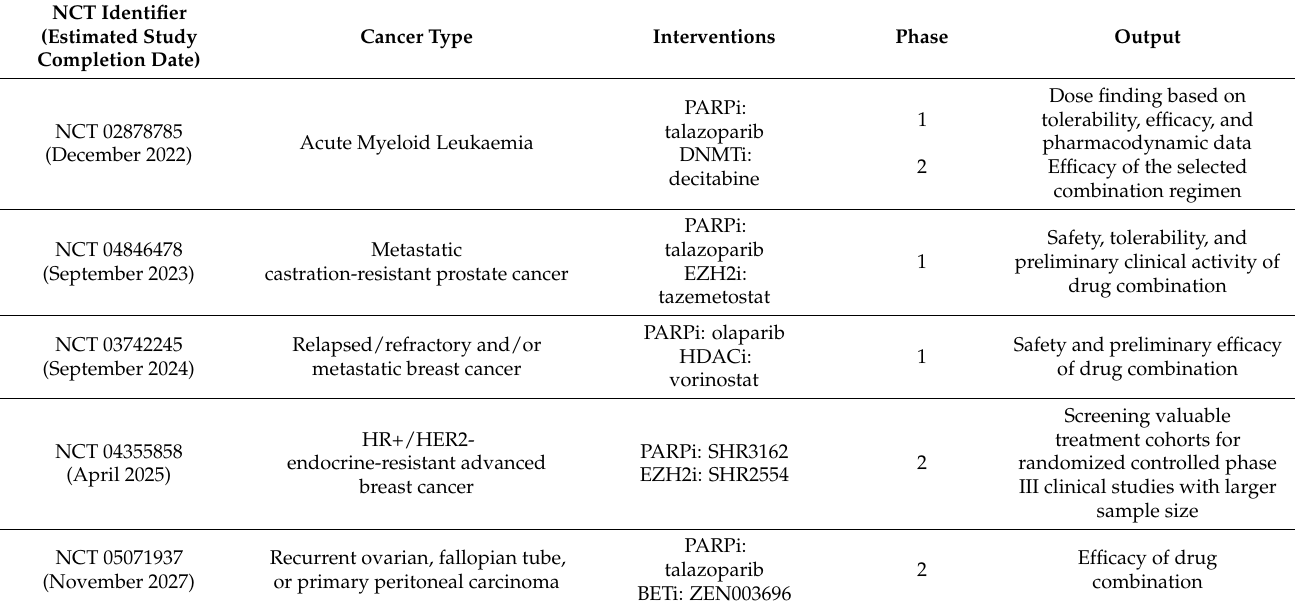
Table 2. Ongoing clinical trials of PARPi in combination with epigenetic